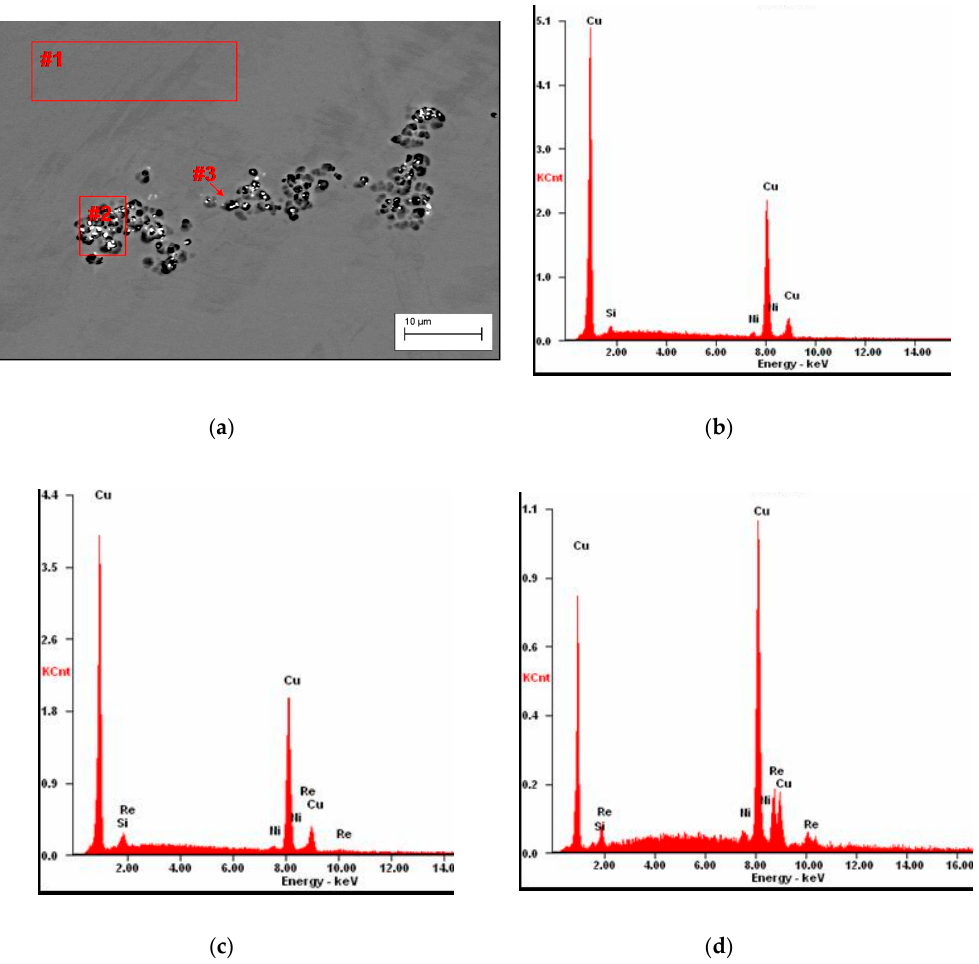
Figure 9. Structure of Cu–2Ni–1Si–0.6Re alloy: supersaturation 950 ◦ C; time 1 h, water cooling (Ar); plastic deformation 50%; ageing 450 ◦ C 1 h (Table 5) ( a ), analysis of EDS from the #1 ( b ), analysis